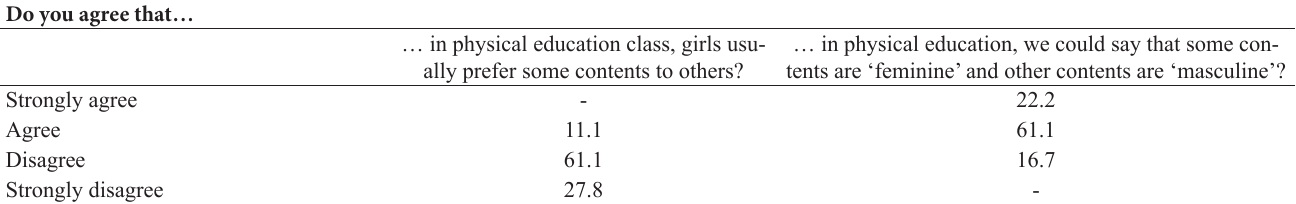
Table 2. Teachers’ degree of agreement (in percentages) concerning girls’ preference for a certain type of content and regarding its femininity or masculinity ( n =